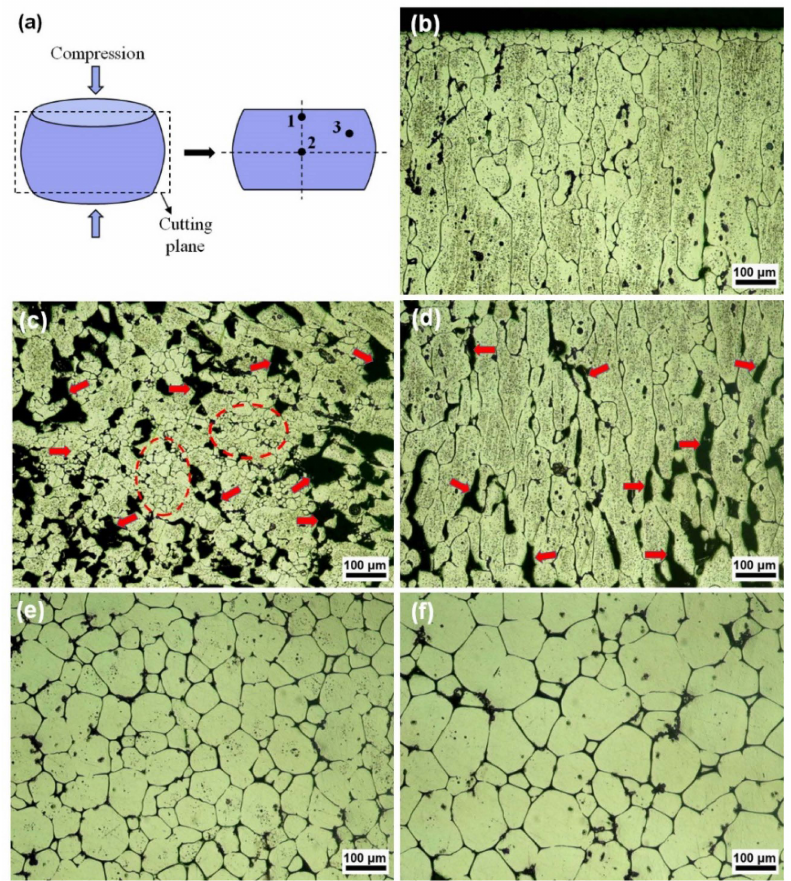
Figure 18. ( a ) Schematic of a hot compressed SIMA sample showing compression direction; Optical micrographs of ( b ) region 1; ( c ) region 2; ( d ) region 3 of SIMA sample processed at 600 ˝ C for 10 min; region 2 of SIMA sample processed at 600 ˝ C for ( e ) 25 min; ( f ) 35 min after hot compression at 600 ˝